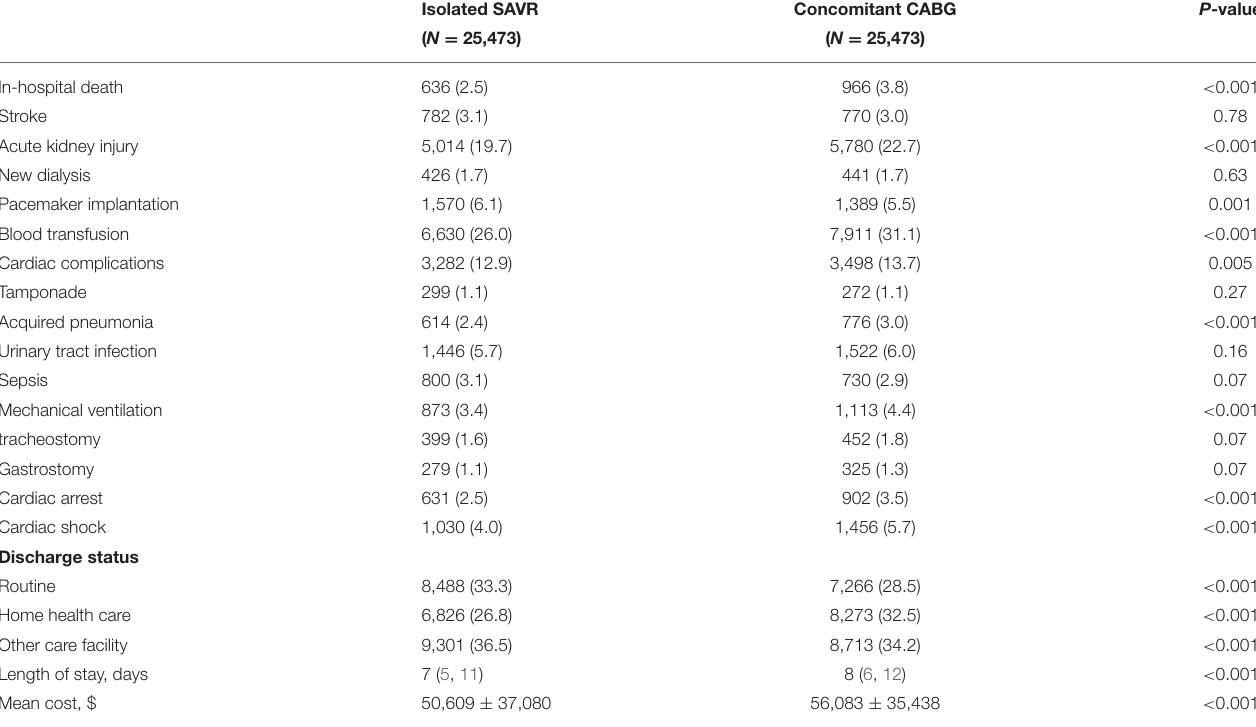
TABLE 3 | In-hospital Outcomes for isolated SAVR and SAVR with concomitant CABG in the Propensity Matched Cohorts. Isolated